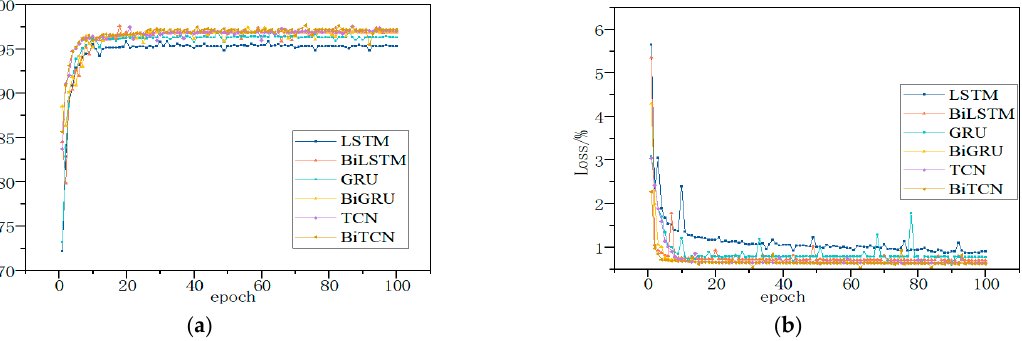
Figure 14. The Evaluation Results Based on DataCon Dataset; they should be listed as: ( a ) Description of accuracy; ( b ) Description of loss.